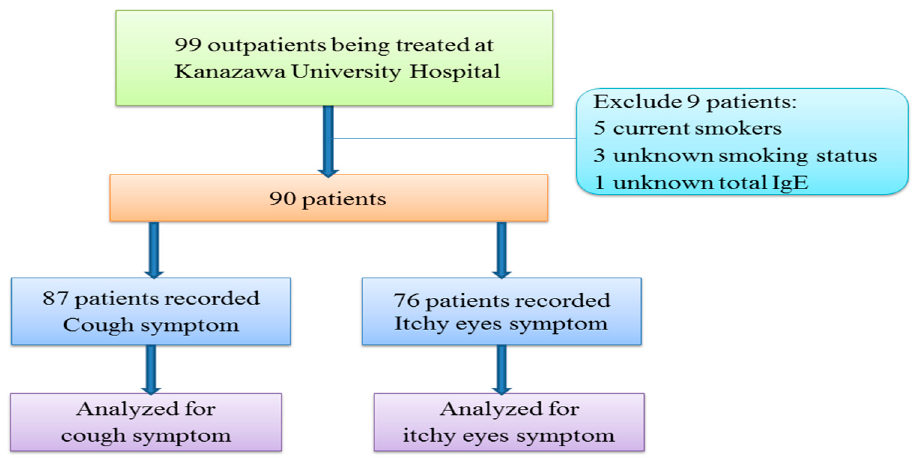
Figure 1. Flow chart showing description of patients in the study.